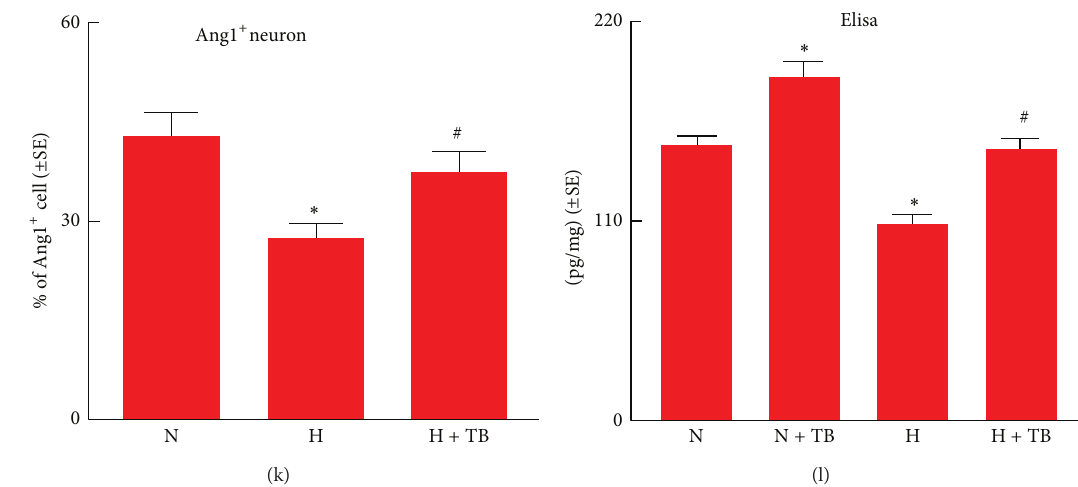
Figure 6: Effect of T 𝛽 4 on Ang1 expression. Representative images of double immunofluorescent staining show that Ang1 immunoreactivity ((b), (c), (e), and (f) red, and arrows) was colocalized to NF-H positive axons ((a) and (c) green and arrows) and S100 positive Schwann cells ((d) and (f) green and arrows) in sciatic nerve tissue on the longitudinal section. Panels (g) to (i) show that Ang1 immunoreactivity ((h) and (i) green and arrows) was colocalized to NF-H positive cells ((g) and (i) red and arrows) in the cultured DRG neurons. Panel (j) shows Western blot analysis (j) of Ang1 in sciatic nerve tissue and 𝛽 -actin was used as an internal control. Panel (k) shows quantitative data of the percentage of Ang1 immunoreactive DRG neurons cultured in normal glucose (N), high glucose (H), and high glucose with T 𝛽 4 (+T Β , 100ng/mL). Panel (l) shows Elisa data of Ang1 levels in supernatants harvested from Schwann cells in normal glucose (N), normal glucose with T 𝛽 4 (N + TB), high glucose (H), and high glucose with T 𝛽 4 (H + T Β ). Bars in 𝐶 and 𝐹 = 50 𝜇 m and 𝐼 = 100 𝜇 m. ∗ 𝑃 < 0.05 versus the nondiabetic (DM) or normal glucose (N), # 𝑃 < 0.05 versus diabetic mice treated with saline (DB) or high glucose (H), respectively. 𝑛 = 6